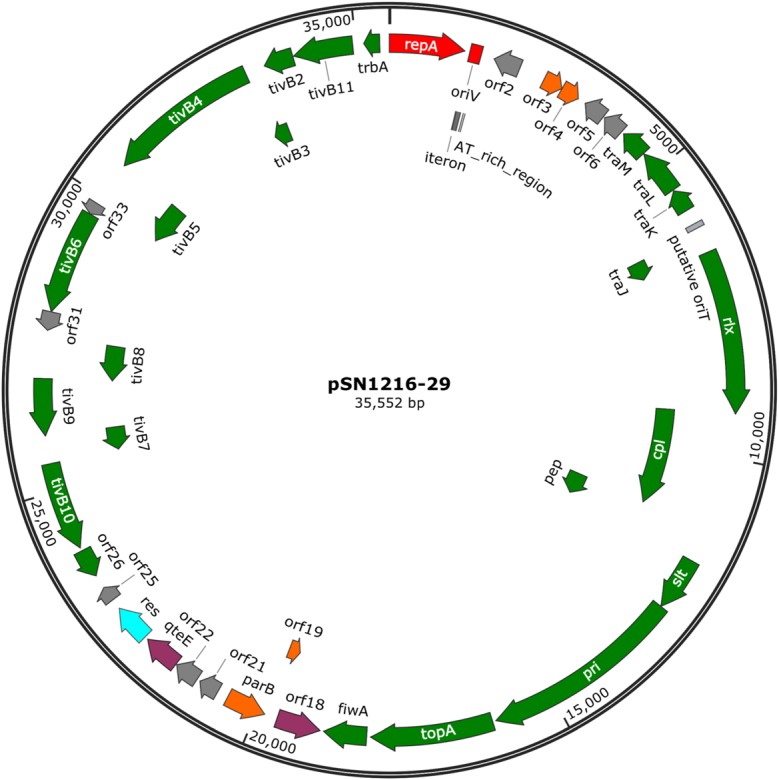
A circular map of plasmid pSN1216-29. Coding sequences are shown as arrows indicating their transcriptional direction. Colors indicate their putative functions: red, replication; orange, maintenance; green, conjugation; light blue, resolvase; gray, a hypothetical protein. The sequences of oriV and putative oriT are indicated by a rectangle.